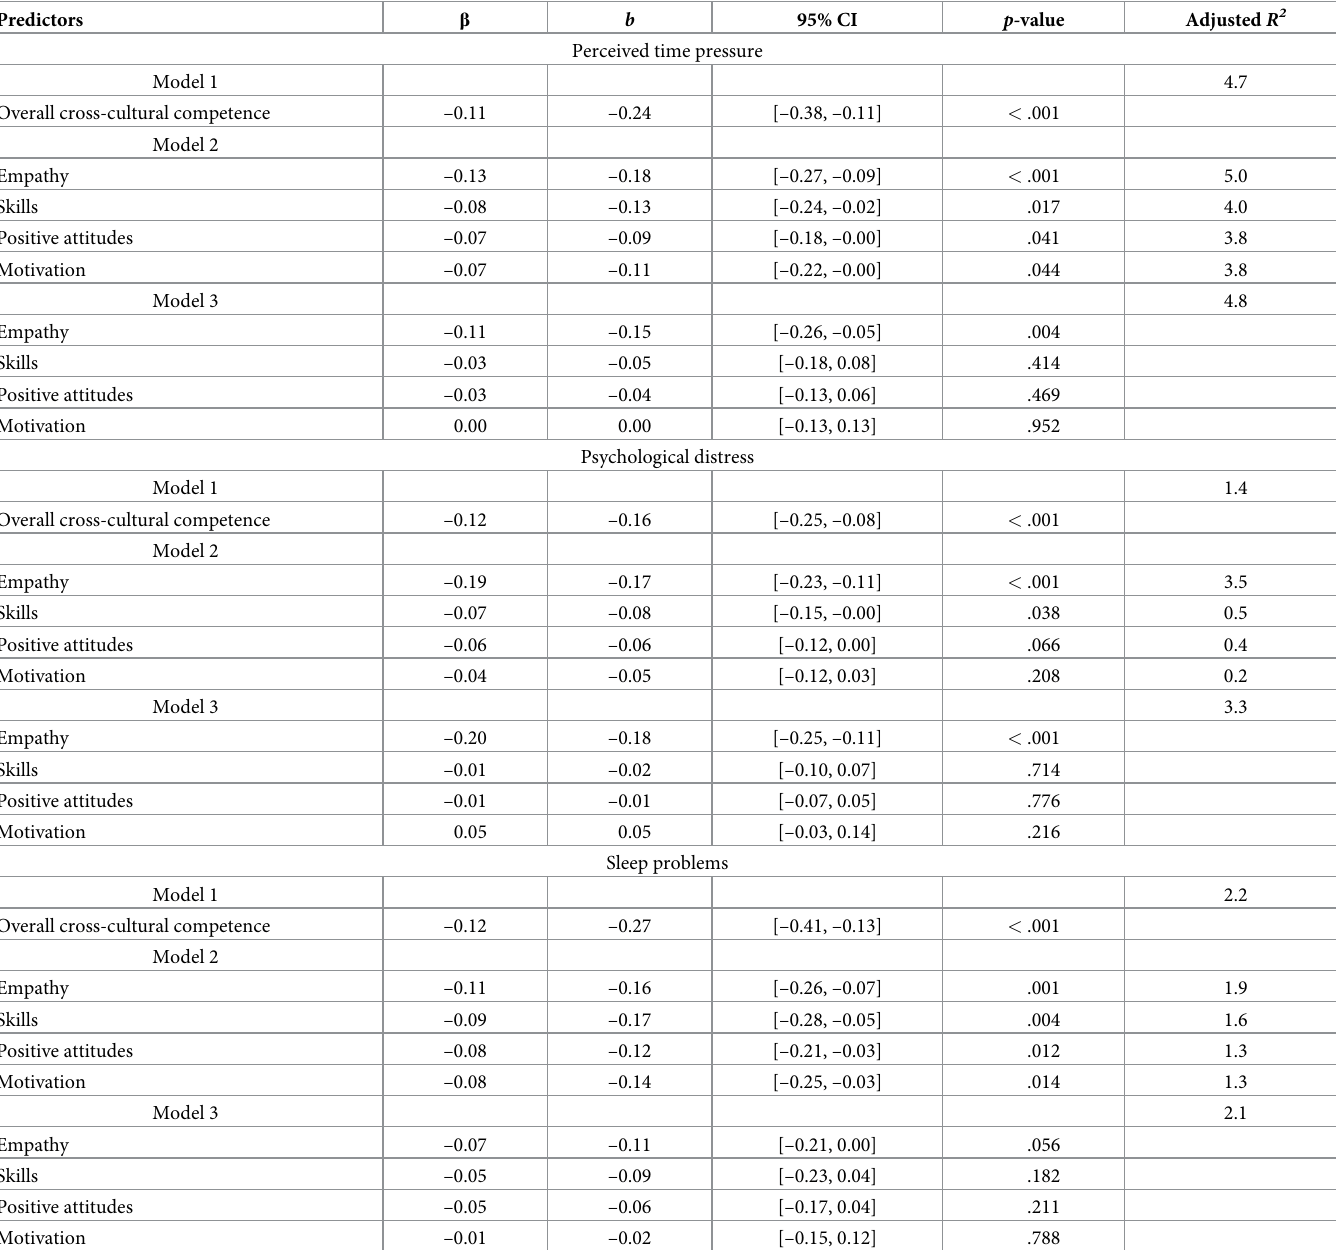
Table 2. The results of the multiple linear regression examining associations of cross-cultural competence with perceived time pressure, psychological distress, and sleep problems (n = 956).